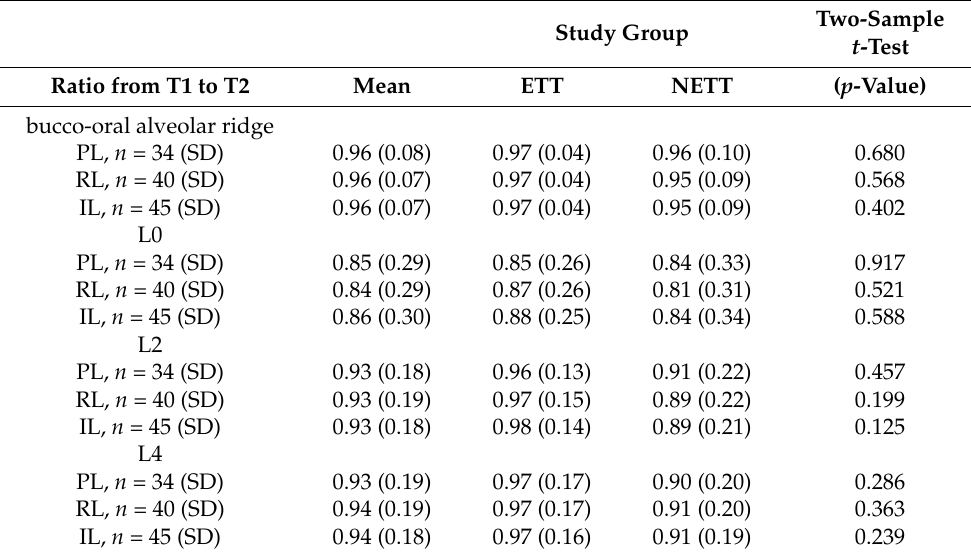
Table 5. Ratio of residual ridge width of bucco-oral alveolar ridge and buccal lamella from T1 to T2.